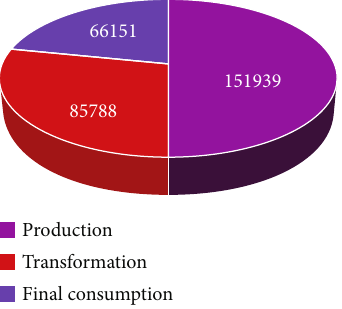
Figure 4: Biofuel production, transformation, and consumption in Ghana [7, 43].